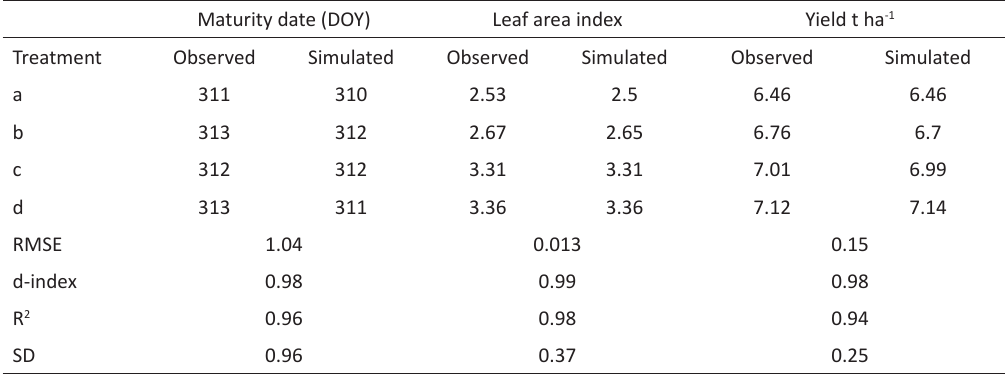
Table 6. Model validation results for winter wheat maturity date (DOY), leaf area index, and yield data (t ha -1 ) together with evaluated statistical parameters - RMSE, D-index, coefficient of determination, and standard deviation